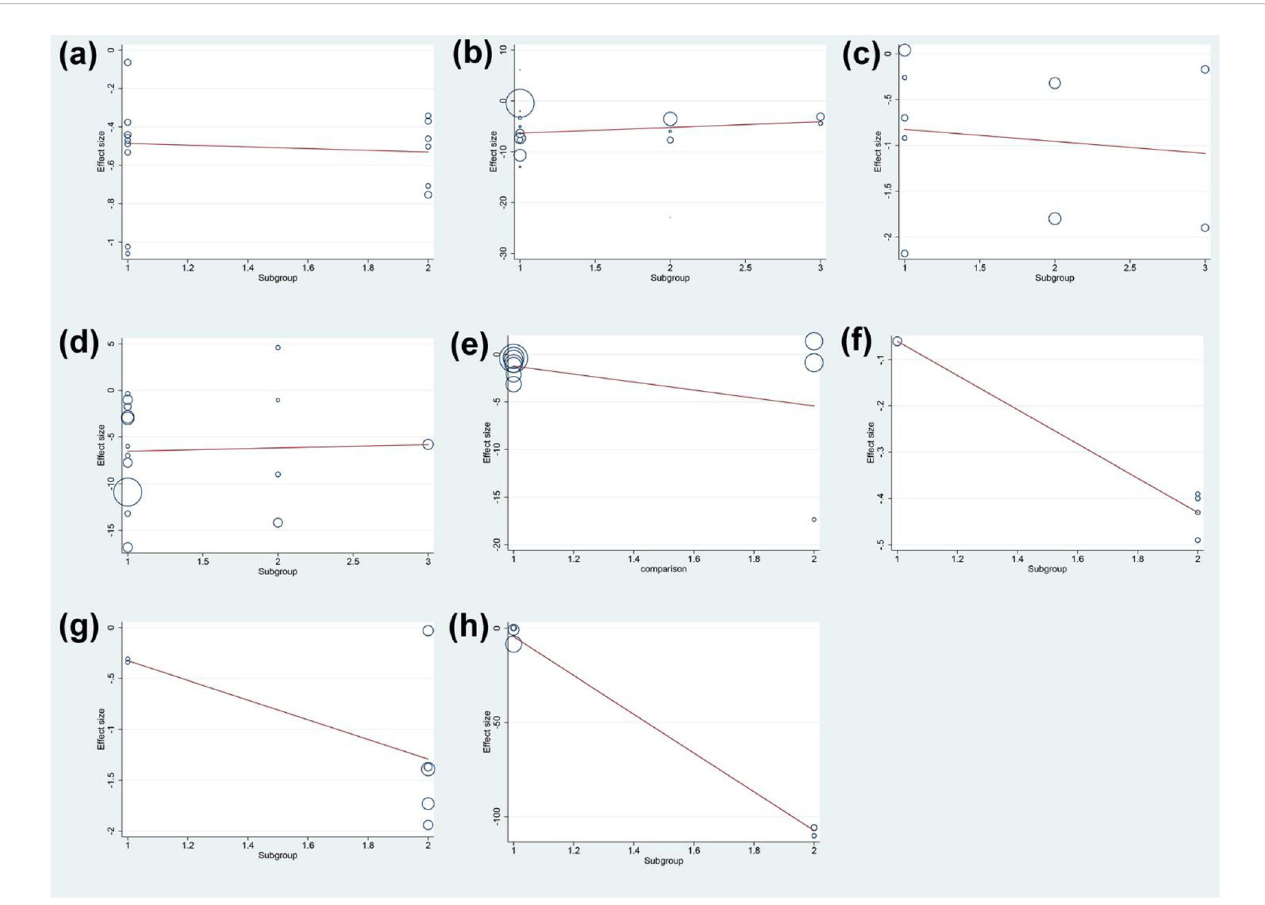
FIGURE 15 Meta-regression Results of the duration of intervention (A) adverse events of total glucosides of paeony; (B) CRP of total glucosides of paeony; (C) DAS28 of total glucosides of paeony; (D) ESR of total glucosides of paeony; (E) RF of total glucosides of paeony; (F) CRP of curcumin; (G) DAS28 of curcumin; (H) ESR of